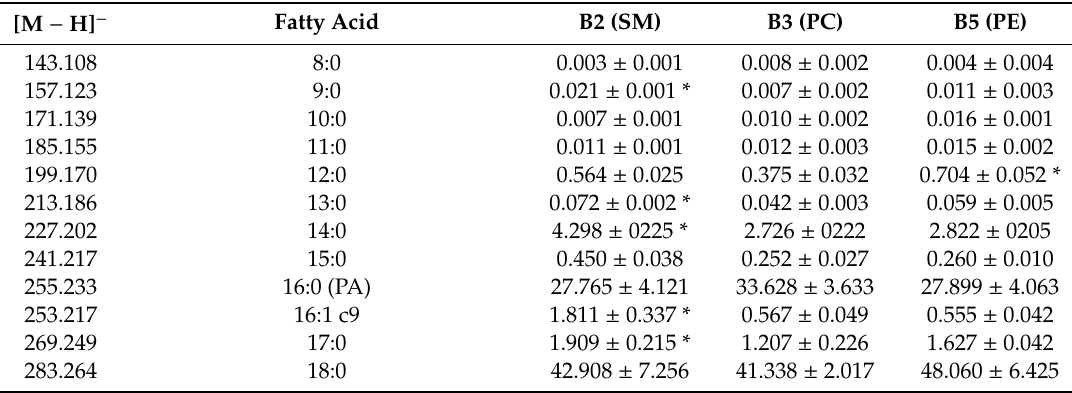
Table 1. The fatty acid profile of the most bioactive PL subclasses of Irish ale